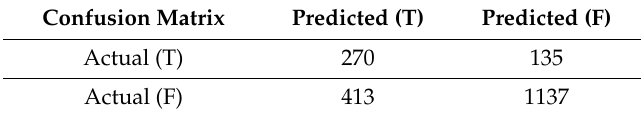
Table 1. Confusion matrix of the proposed method.